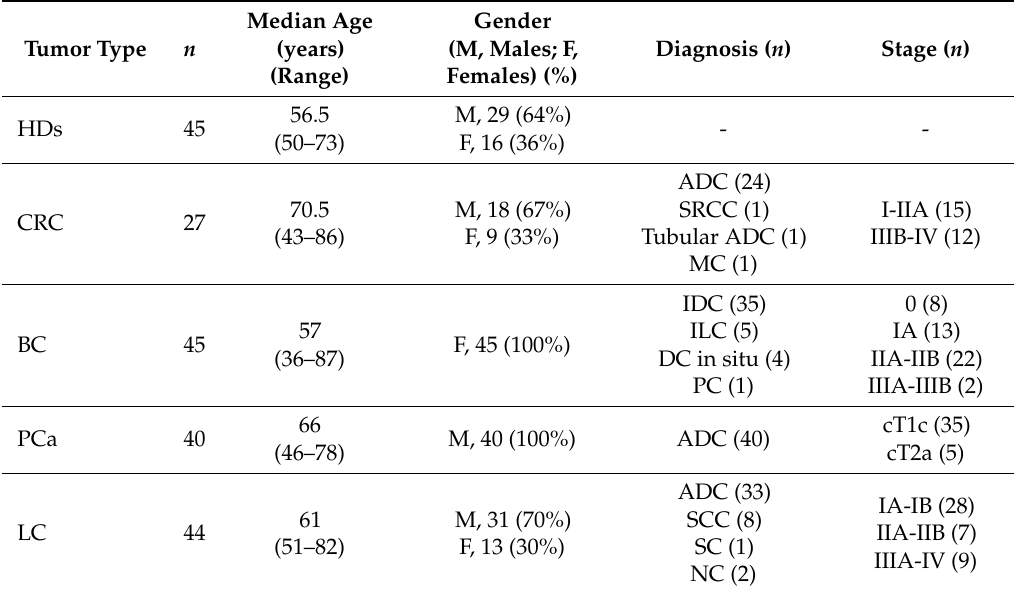
Table 3. Clinical and histopathological characteristics of